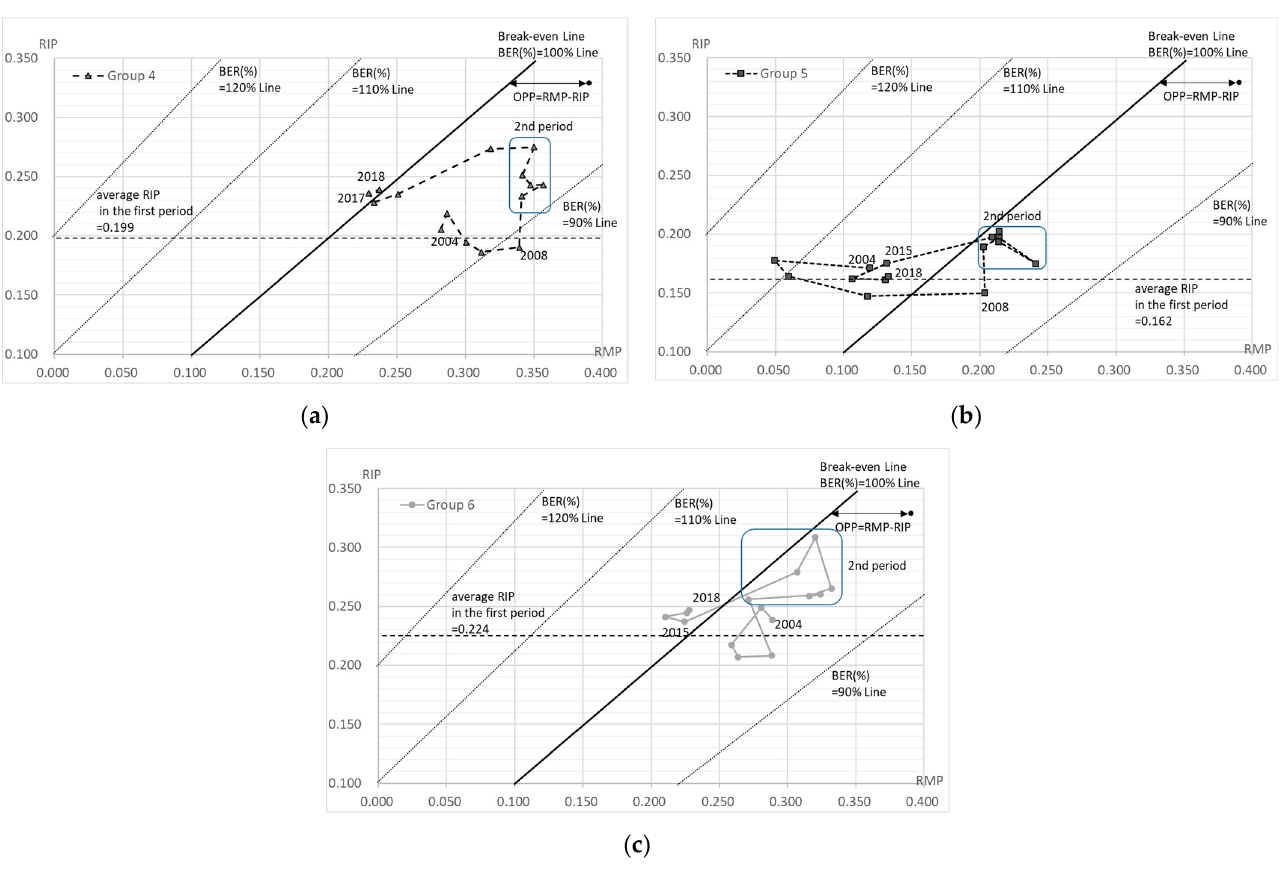
Figure 6. RMP, RIP, OPP, and BER in hospitals offering chronic-phase medical care. ( a ) Group 4 (hospitals offering medical care for disabilities); ( b ) group 5 (hospitals offering psychiatric medical care); ( c ) group 6 (hospitals offering mixed medical care). The OPP shows the difference between RMP and RIP; OPP = RMP − RIP. Break-even Line; RIP = RMP. 90% line of break-even ratio (BER (%)): RIP = 0.9RMP − 0.1, calculated by the formula: RIP = BER (RMP + 1) − 1. 110% line of BER (%): RIP = 1.1RMP + 0.10. 120% line of BER (%): RIP = 1.2RMP + 0.20.